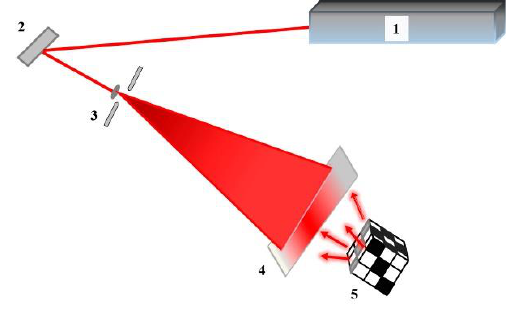
Figure 2. The schematic diagram of the recording of display holograms by the method of Yu. N. Denisyuk: 1 - laser, 2 - mirror, 3 - pinhole microlens system, 4 - photosensitive plate, 5 - object.